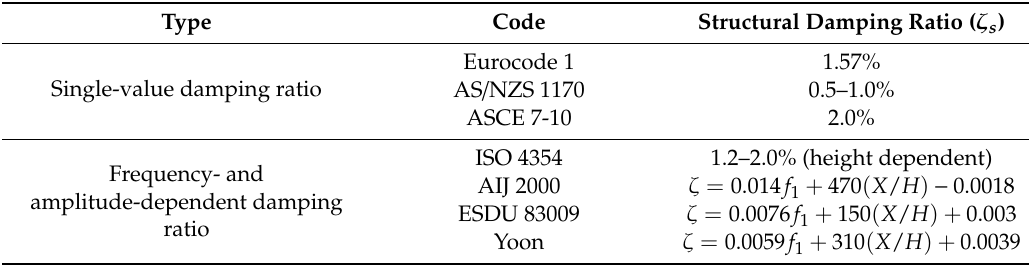
Table 6. Structural damping ratios of RC